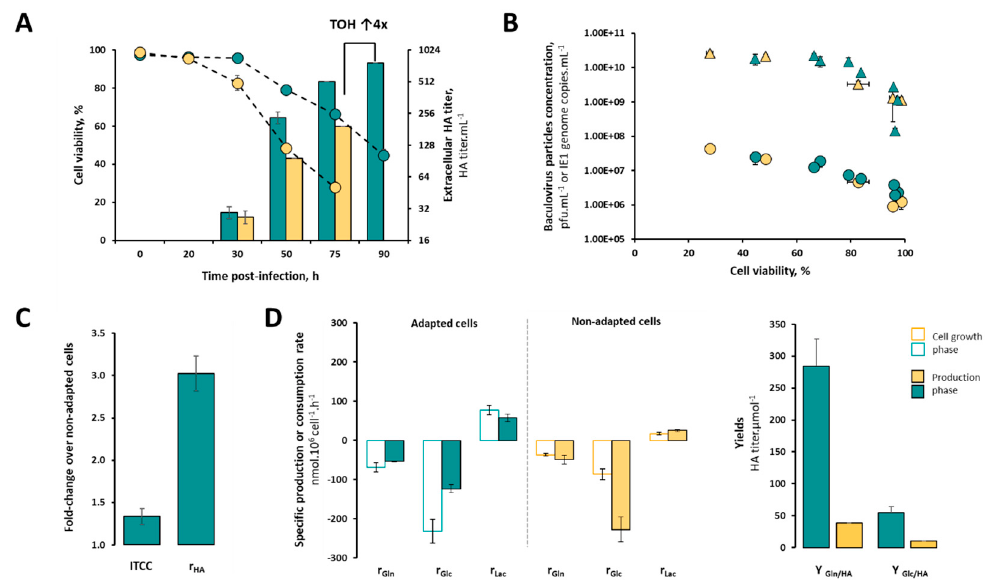
Figure 3. Infection kinetics, HA expression and cell metabolism read-outs of adapted and non-adapted High Five cells during production of influenza VLPs. ( A ) Cell viability (%) and extracellular HA titer (HA titer.mL − 1 ) profile upon infection; ( B ) infectious (circles, pfu.mL − 1 ) and total (triangles, IE1 genome copies.mL − 1 ) baculovirus titers upon infection; ( C ) fold-change (adapted / non-adapted) of total number of cells during production phase (ITCC, 10 6 cell.mL − 1 .h) and specific HA productivity (r HA , HA titer.cell − 1 .h − 1 ); ( D ) specific consumption rate of glucose (r Glc , nmol.10 6 cell − 1 .h − 1 ) and glutamine (r Gln , nmol.10 6 cell − 1 .h − 1 ), specific production rate of lactate (r Lac , nmol.10 6 cell − 1 .h − 1 ), and yields of product (HA) formed per substrate (Glc or Gln) consumed; i.e., Y Glc / HA and Y Gln / HA . Color code: green represents data for adapted cells, and yellow represents data for non-adapted cells. Data are expressed as mean ± standard deviation (relative to three biological replicates, n = 3).